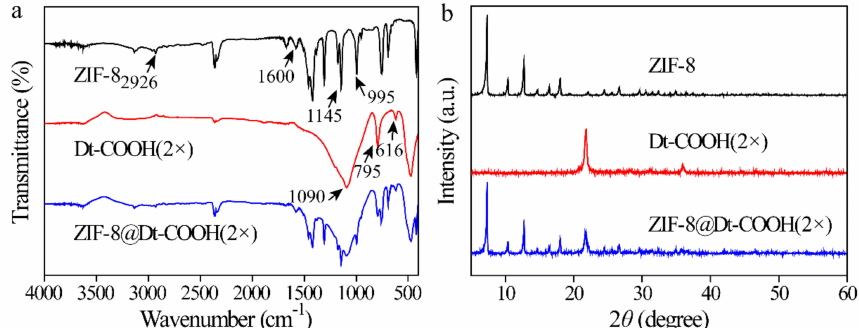
Figure 3. ( a , b ) FT-IR spectra and XRD patterns of ZIF-8, Dt-COOH(2 × ) and ZIF-8@Dt-COOH(2 × ).